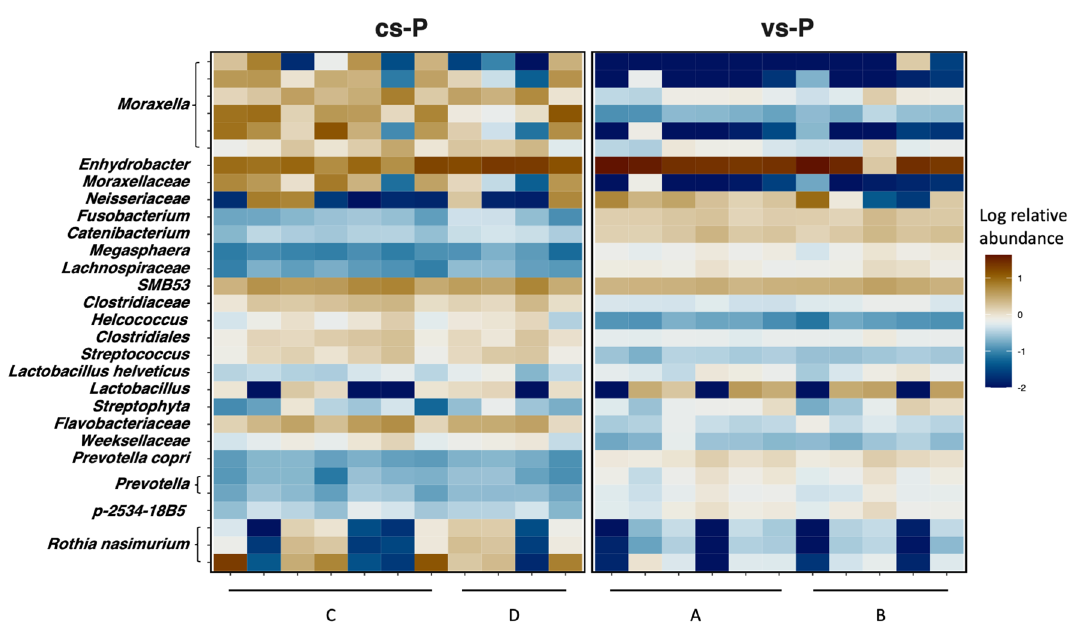
Figure 3. Heatmap representing the top 30 most relative abundant ASVs globally. The relative abundance (log10) of each ASV in the nasal microbiota of piglets from control sows (cs-P) and vaccinated sows (vs-P) is shown. The biological mothers are indicated in the bottom as A, B, C and